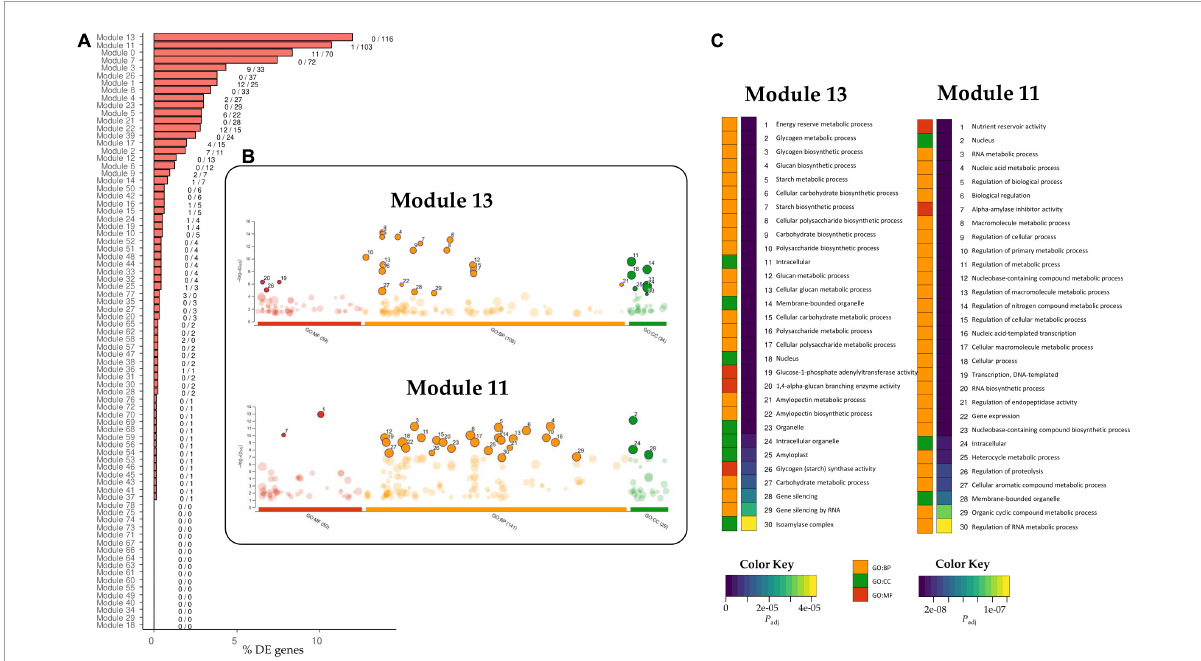
FIGURE5 (A) Percentage of differentially expressed (DE) genes that belong to each module in the Weighted Gene Co-expression Network Analysis (WGCNA) network for grain tissue. The label close to the bars indicates the number of up/down-regulated genes in each module. (B) Manhattan plot of the Gene Ontology (GO) enrichment analysis of genes in modules 13 and 11 of the WGCNA network from grain tissue. The number of enriched GOs per domain is indicated between parentheses. The enriched GOs are represented, and the top 30 GO enriched are highlighted. (C) The adjusted P -value with the Benjamini-Hochberg method of the top 30 enriched GOs is represented per domain in modules 13 and 11. GO:MF, Molecular Function domain; GO:BP, Biological Process domain; GO:CC, Cellular Component